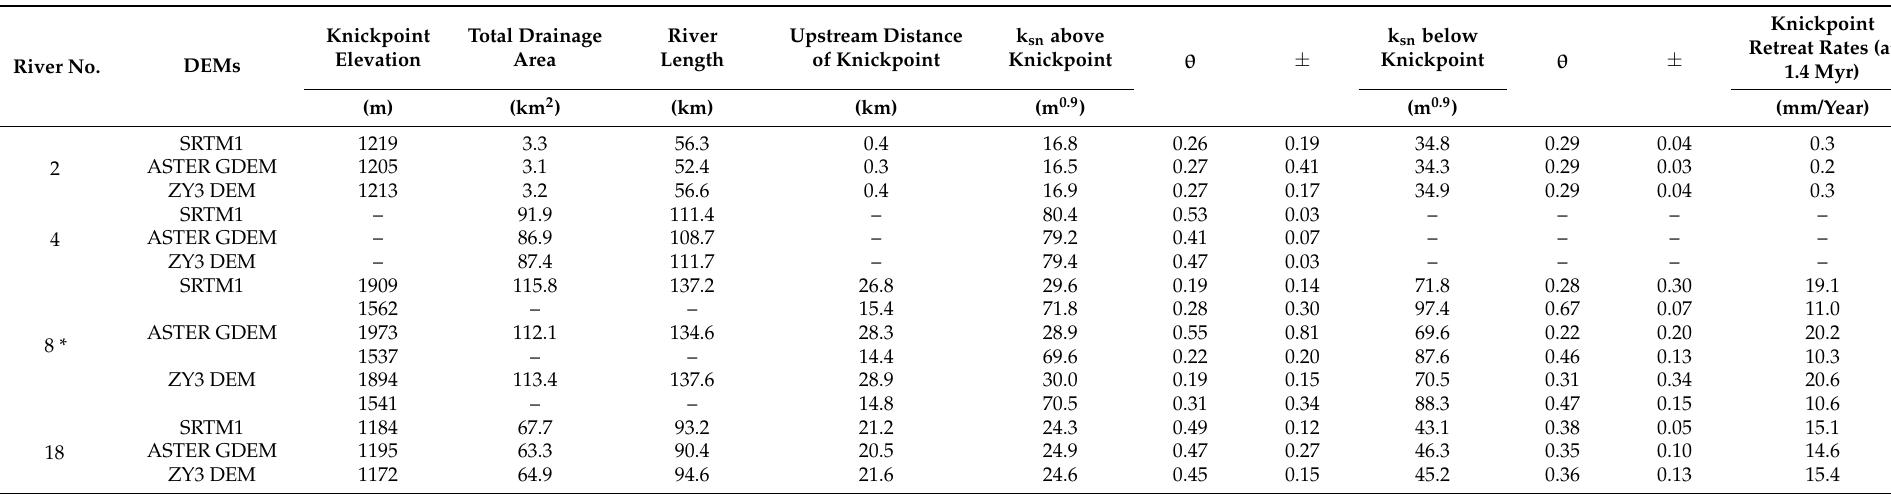
Table 5. Comparison of river long profiles related to different DEMs. * donates rivers with second (higher) knickpoints.